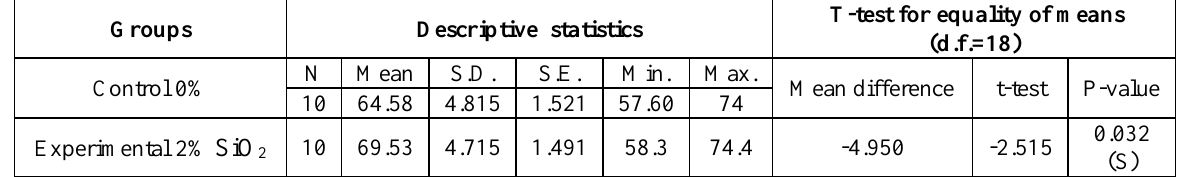
Table 1: Descriptive summary and T-test for transverse strength (N/mm 2 ) Descriptive statistics Groups